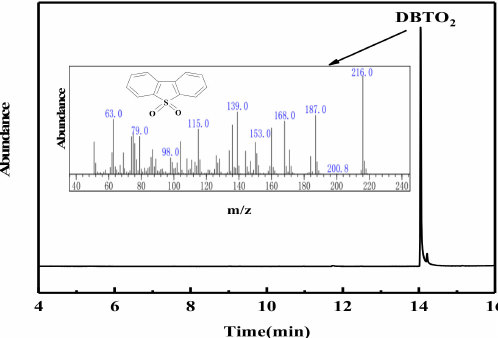
Figure 12. Gas Chromatography-Mass Spectrometry (GC-MS) analysis of catalyst after